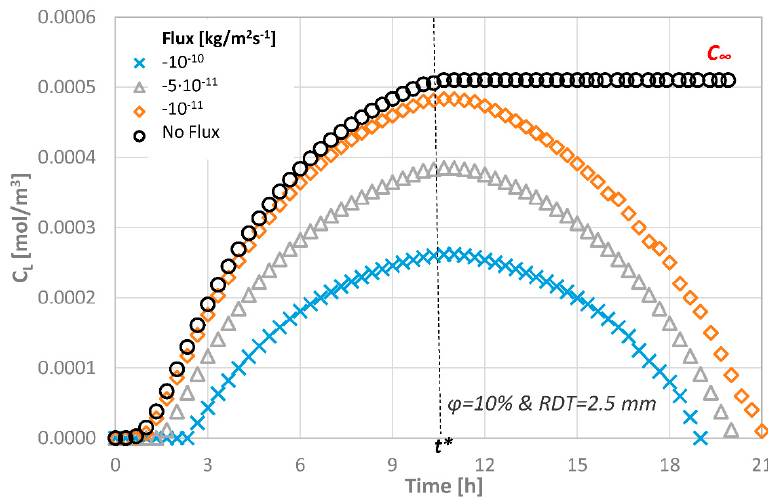
Figure 6. Molar concentration at the pulpal side of the dentinal discs as a function of different consumption rates for φ = 10% and RDT = 2.5 mm.